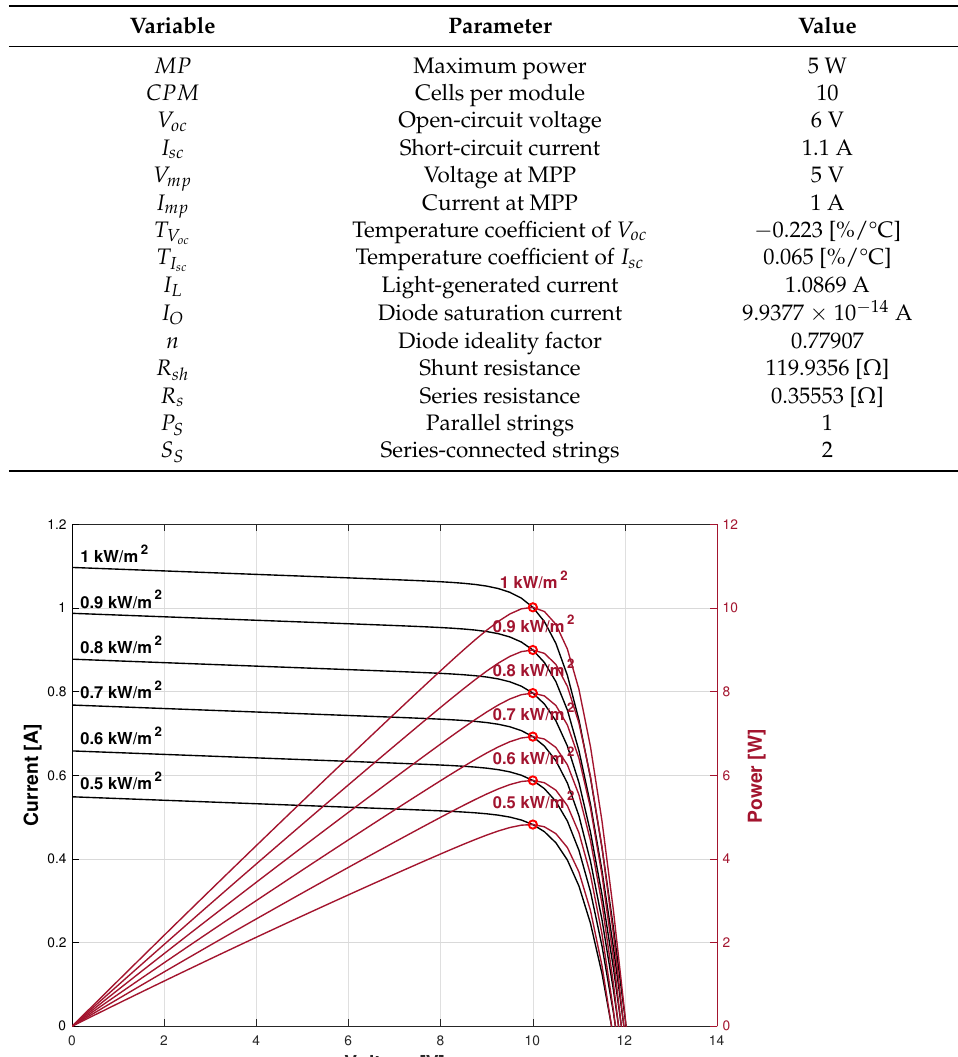
Table 2. Main operating parameters of the FIT0600 PV module.